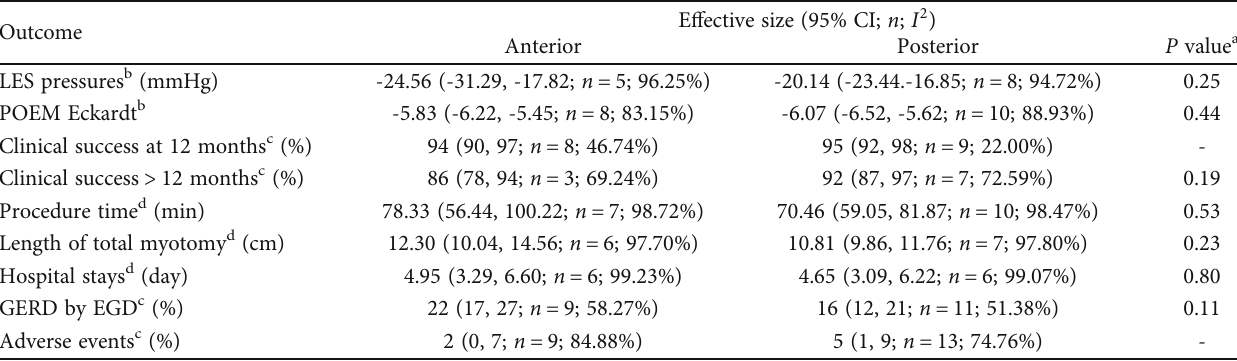
Table 3: Summary of the results before balancing baseline.